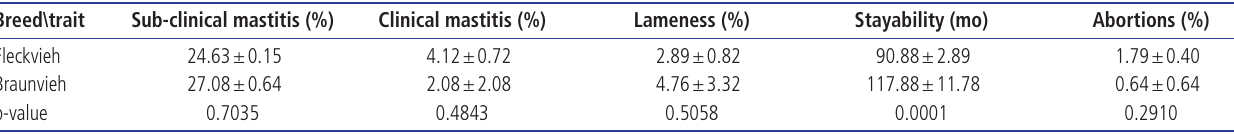
Table 3. Averages (±SEM) for functional traits in Fleckvieh and Braunvieh cows